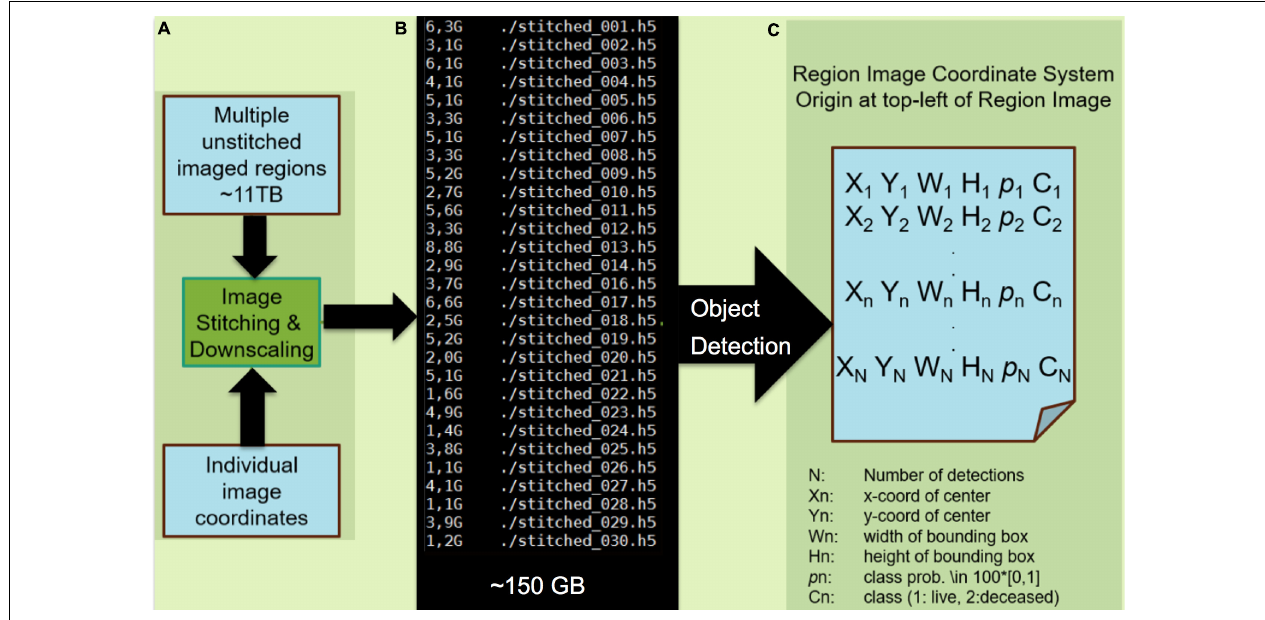
FIGURE 4 | Processing of images and application of the machine learning classification algorithm. (A) Module A preprocesses the mSEM output by stitching individual images into region-wide panoramas by the virtue of recorded image coordinates. In the interest of computational efficiency, the resulting image is down-scaled such that individual cells occupy circa 200 × 200 pixels. Here, the 11TB mSEM output from the 3rd generation map is stitched into 30 image regions amounting to 150 GB of data after downscaling. (B) Module B applies the pretrained object detector. (C) The output is a file listing that includes the location of each detected cell as a bounding box (X,Y,W,H), class (viable/pyknotic, annotated as “deceased”) and associated confidence p . Each of N detections results in a set of five predictions for each corresponding bounding box, including the x and y coordinates of the center of the bounding box (X n ,Y n ), width and height of the bounding box (W n ,H n ), and the confidence of the detection ( p n where a confidence or probability of 0 means no object was detected and 1.0 means a perfect match with "ground truth"). The object is then further classified as live or deceased (C n ). The object detector is pretrained using 600 living and 50 pyknotic examples (Knothe Tate et al., 2016b) and took 12 h to train on a single graphics processing unit (GTX1080). The testing phase on the 150 GB dataset lasted 100 h. Note: modules A and B can be combined into a single